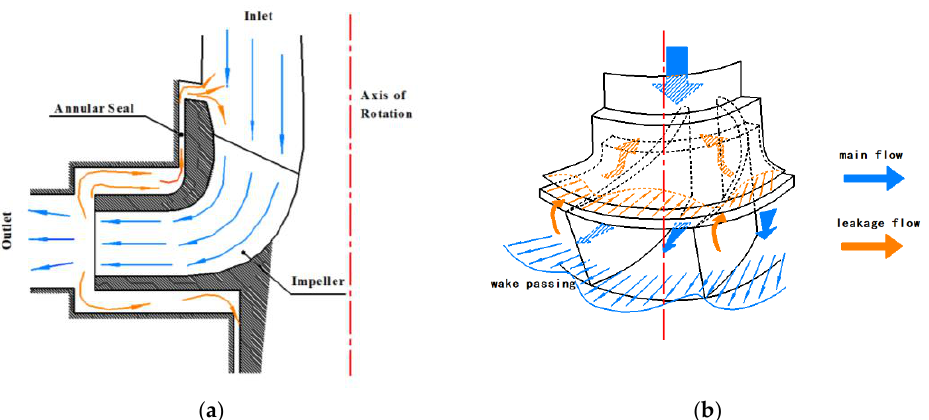
Figure 9. Sketch diagram of wake turbulence affecting inflow distortion of the annular seal. ( a ) Meridian plane ( b ) 3-D model.